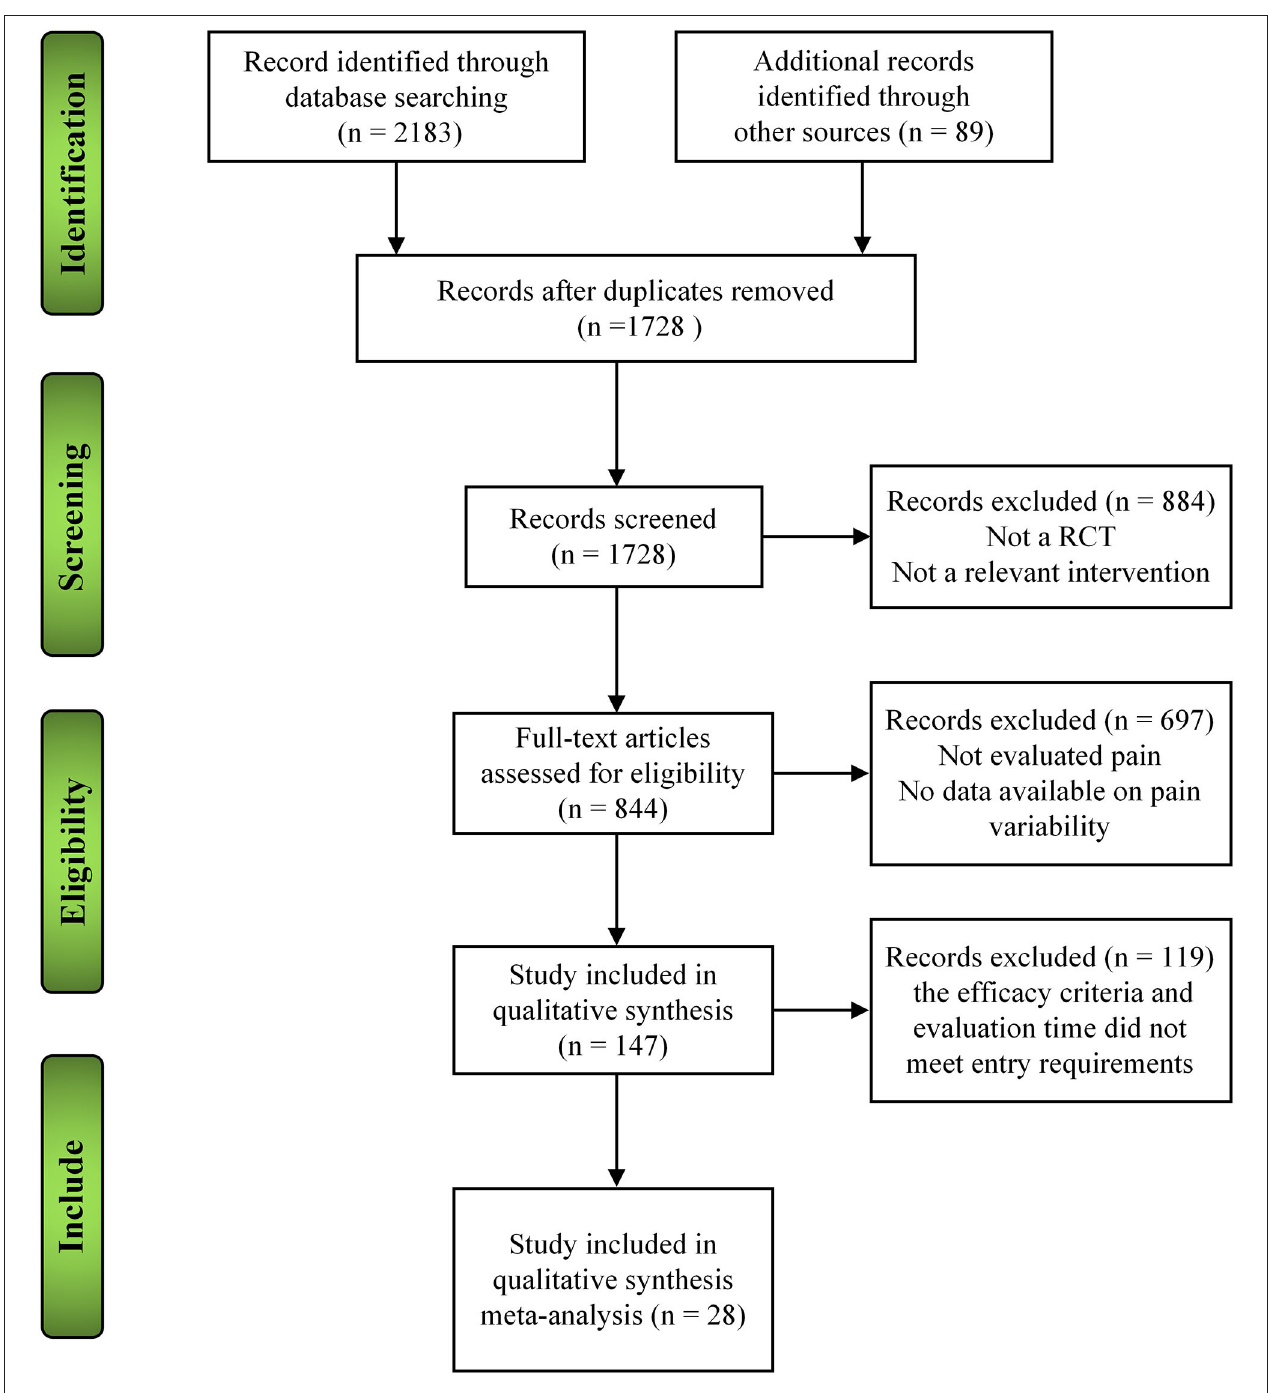
FIGURE 1 | The different phases of the search of the 8 databases and the selection of the studies included in the present analyses.